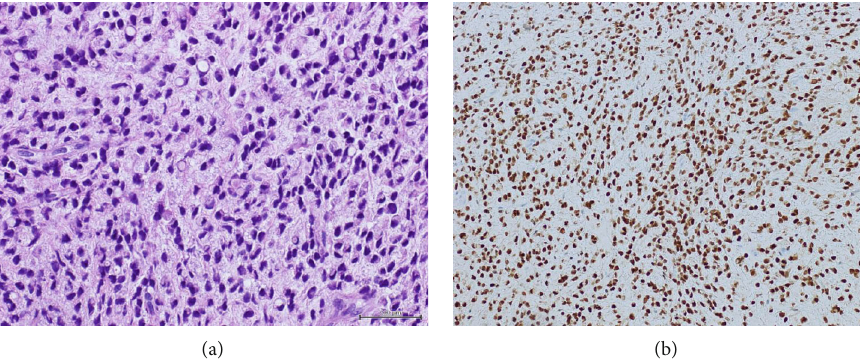
Figure 6: (a) Peritoneal deposit biopsy showing discohesive cells with plasmacytoid and signet ring morphology. (b) Peritoneal deposit biopsy showing sheets of malignant cells positive for estrogen receptors (ER).